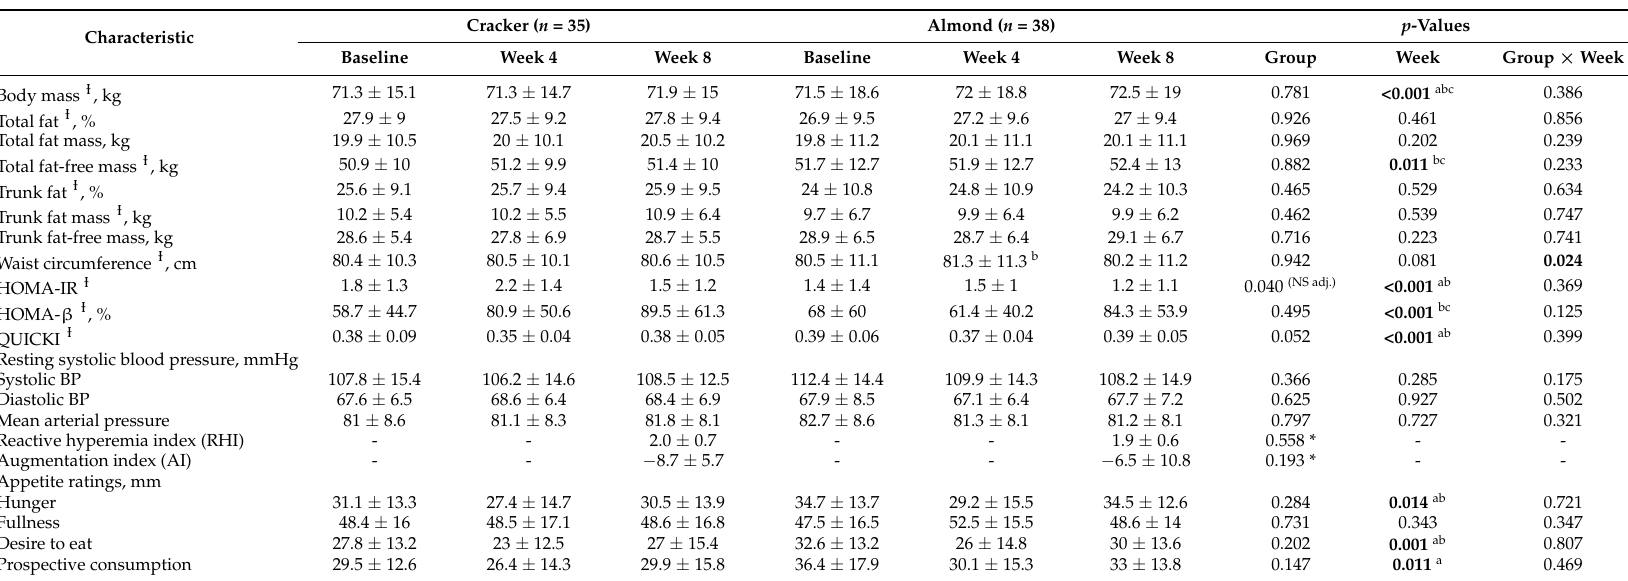
Table 3. Anthropometric, clinical, cardiovascular and appetite outcomes in the cracker and almond groups at baseline, week 4 and week 8 of the study. Characteristic Cracker ( n = 35) Almond ( n = 38) p -Values Week 8 Group Week Group × Week